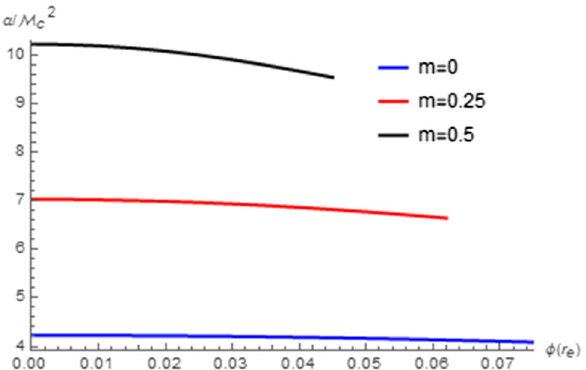
Fig. 16 The ‘mass’ M c = M ( r c ) for the scalarized black hole as a function of φ( r e ) for different scalar